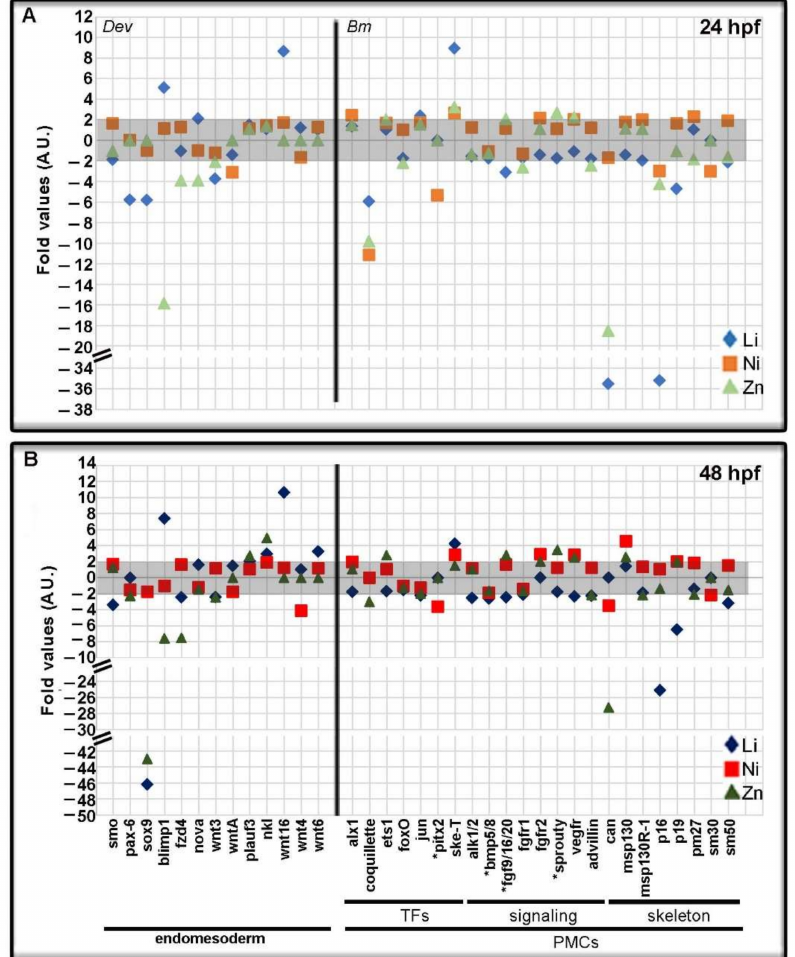
Figure 6. Development and Biomineralization genes with endomesoderm and mesoderm (primary mesenchyme cells, PMCs) expression modulated by Li, Ni, and Zn treatments. The grey boxes indicate the threshold for insignificant changes following Li, Ni, and Zn treatments, i.e., fold values between − 2 and + 2, at 24 ( A ) and 48 ( B ) hours post-fertilization (hpf). Symbols in the plot at 24 hpf ( A ): light blue rhombus, Li-embryos; orange square, Ni-embryos; light green triangle, Zn- embryos. Symbols in the plot at 48 hpf ( B ): blue rhombus, Li-embryos; red square Ni-embryos; green triangle, Zn-embryos. The Development genes here considered have endomesoderm expression. Biomineralization genes, mainly expressed by the PMCs, were organized taking into consideration their functions, i.e., transcription factors (TFs), signaling molecules (signaling), and skeleton structures (skeleton). Asterisks (*) indicate genes also expressed in other